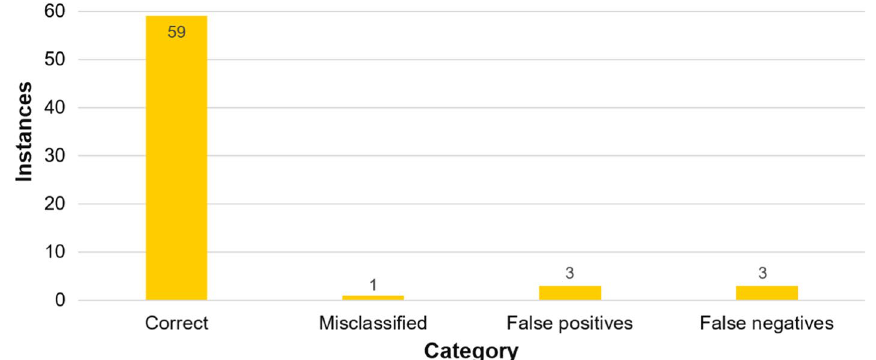
Fig. 13 Prediction breakdown from a pilot session conducted with the SEAT concept car yielded an accuracy of 89%